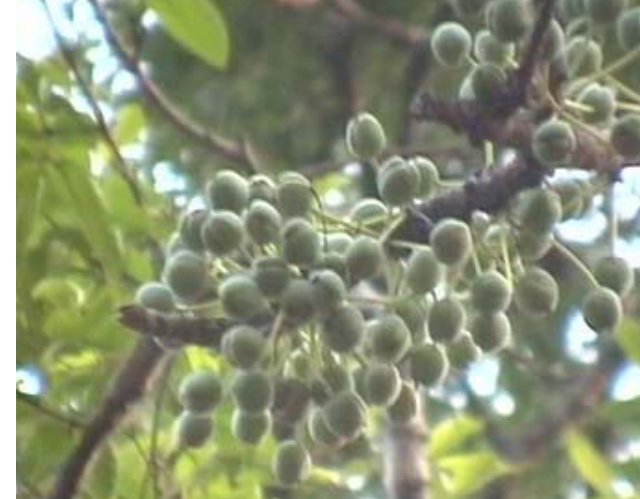
Image 1. Fruits of Dillenia